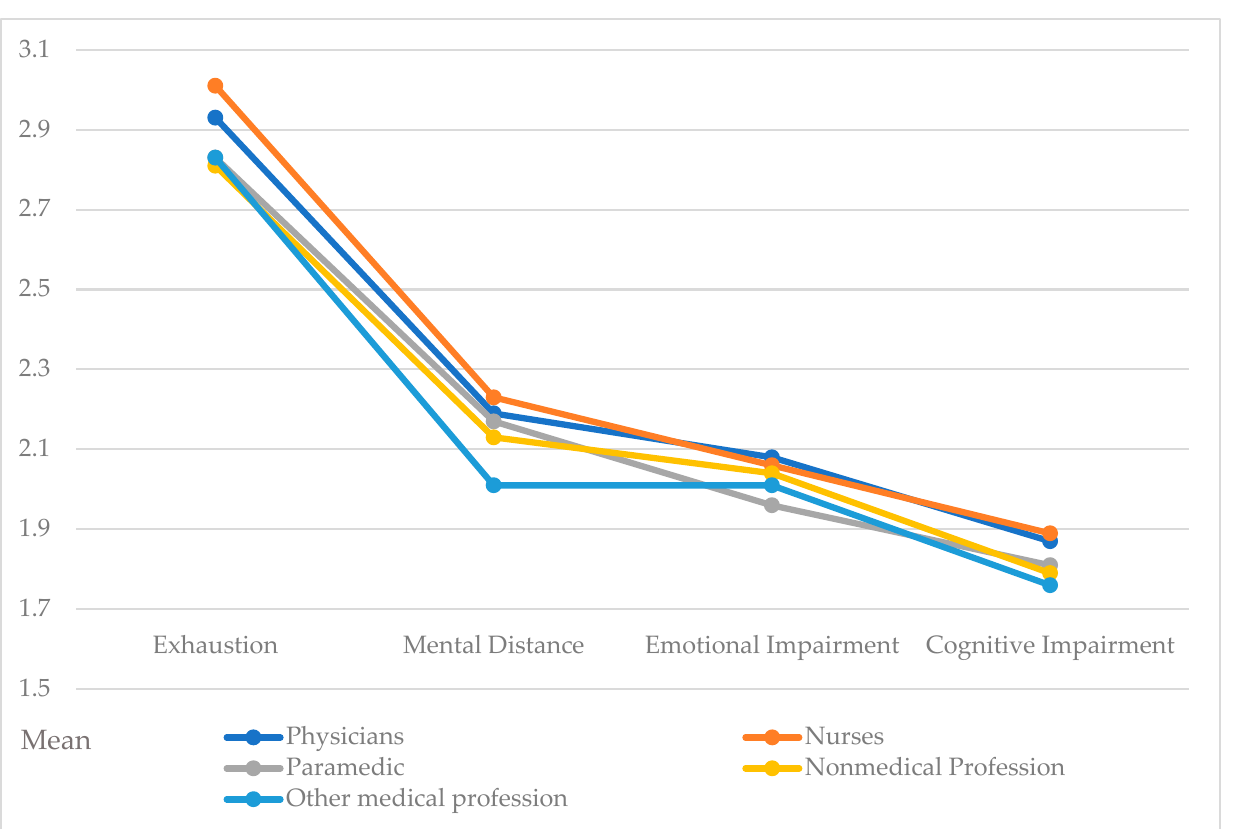
Table 4. Mean occupational burnout profile scores by profession (N = 2196).